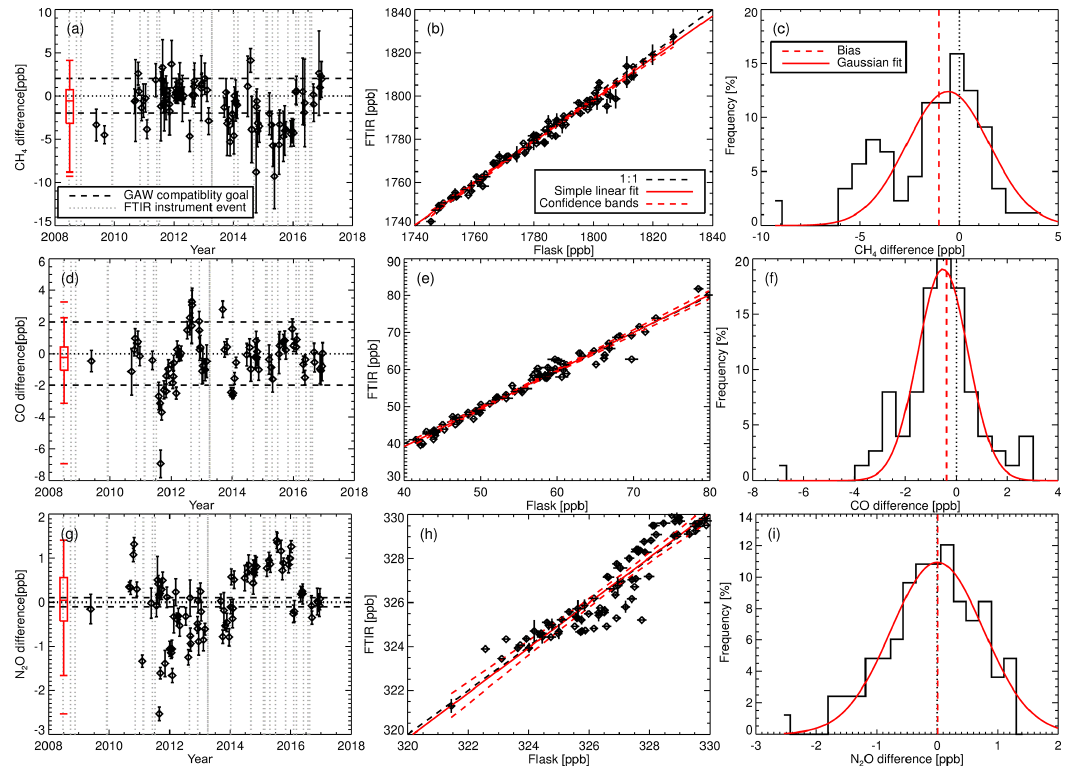
Figure 14. (a) CH 4 FTIR flask comparison. A time series of differences between FTIR and flask measurements (FTIR minus flask). Error bars are the uncertainty in the flask measurements added in quadrature with the FTIR 1h variability. The horizontal dashed line is the GAW-recommended compatibility goal. A box plot statistical summary of the FTIR flask differences is overlaid in red. (b) CH 4 FTIR flask correlation plot. The simple linear regression line is over plotted in red. The red dashed lines are the Working–Hotelling 90% confidence bands. For reference, the 1 : 1 correlation line is indicated the black dashed line. (c) Histogram of FTIR flask differences. The dashed vertical red line is the mean difference (bias). The red line is a Gaussian fit to the histogram to illustrate the deviation of the differences from that of a theoretical random Gaussian statistical distribution based on the given data set. Panels (d) – (f) are the same as (a) – (c) but for CO. Panels (g) – (i) are the same as (a) – (c) but for N 2